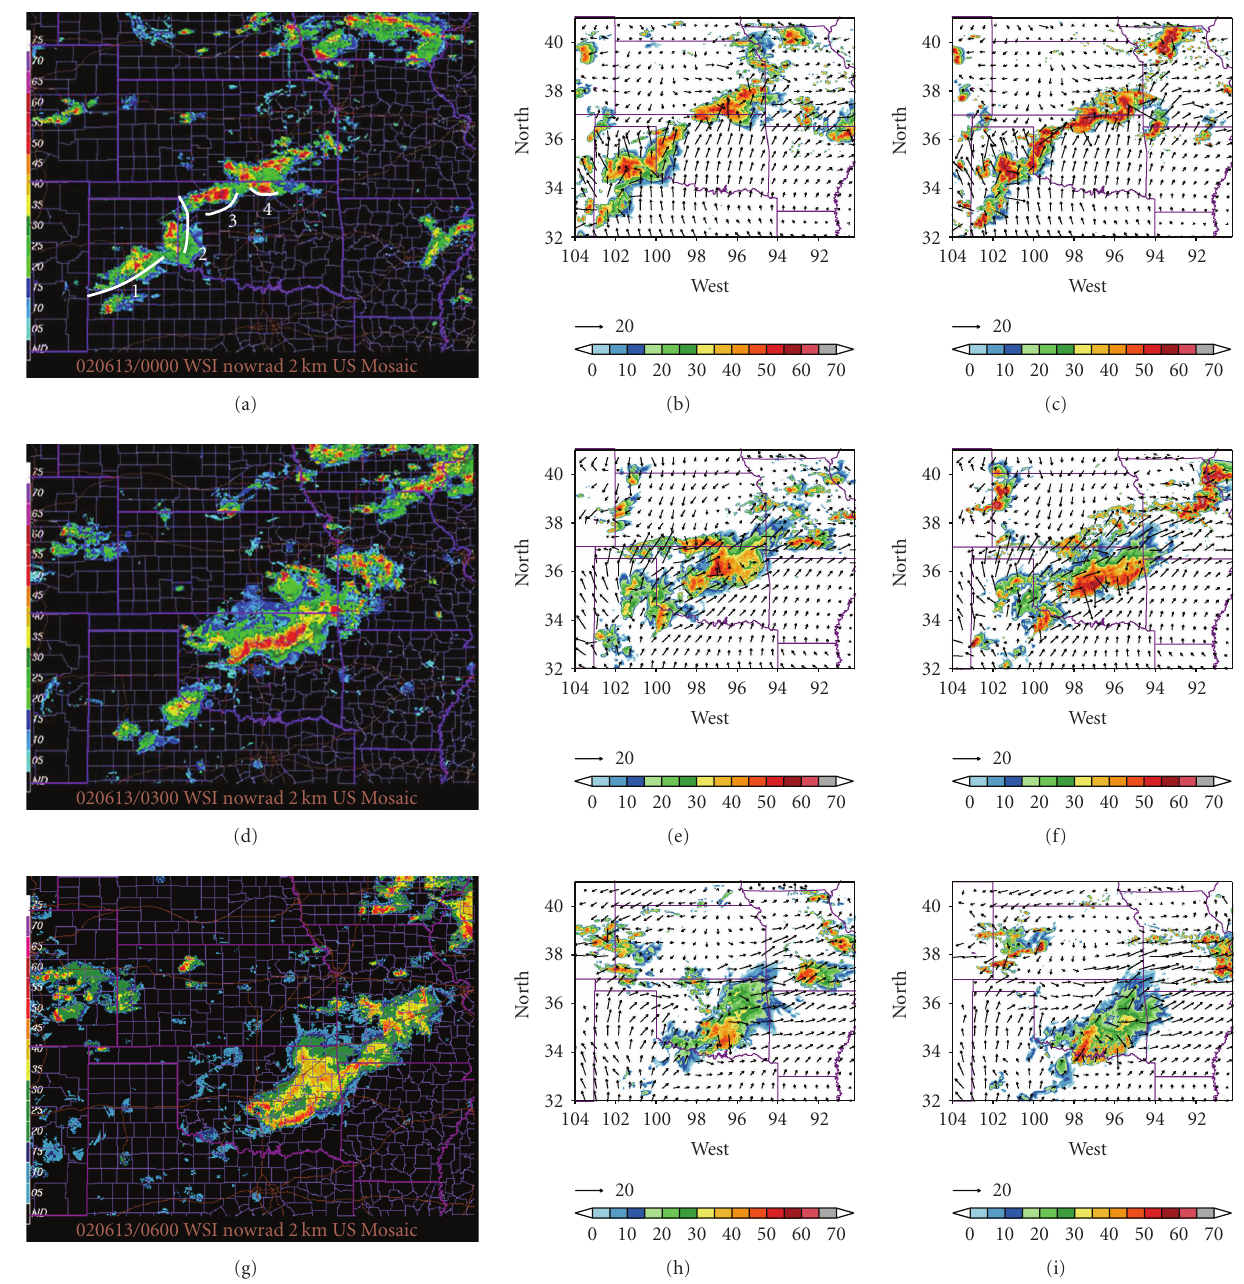
Figure 1: Radar reflectivity (in dBZ) and numbered gust fronts for a squall line case over the US. (a) The observed WSI IHOP Sector Mosaic reflectivity (2-km) at 00UTC 13 June 2002 (URL: http://data.eol.ucar.edu/codiac/dss/id = 77.091). Note that these images are a vertical composite of reflectivity and depict the highest reflectivity measured over each point on the Earth’s surface. (b) and (c) are from the WSM6 and WDM6 experiments, respectively. The reflectivities were calculated from model-simulated precipitation particles (rain, snow, and graupel). The plotted results are from the second domain (i.e., 3-km resolution). Three figures in the second row are the same as (a), (b), and (c), except they were observed at 03UTC 13 June 2002. Figures in the third row represent same fields at 06UTC 13 June 2002. Here, the vectors denote the 850-hPa wind (ms − 1